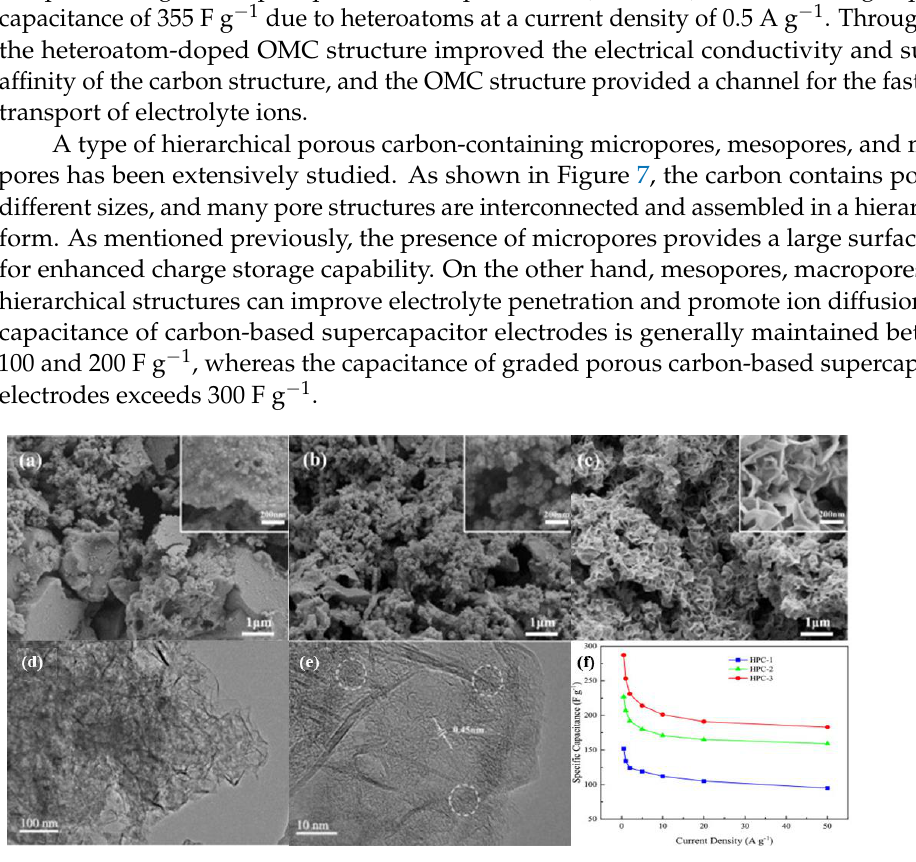
Figure 7. SEM images of ( a ) pore structure of hierarchical porous carbon (HPC − 1) ( b ) foam-like pore structure of hierarchical porous carbon (HPC − 2), ( c ) layered structure of hierarchical porous carbon (HPC − 3), ( d , e ) TEM images of HPC − 3 ( f ) The plot of the Gravimetric specific capacitances of HPCs at different current densities. Reproduced with permission [138] Copyright © 2022, Journal of Energy Storage.